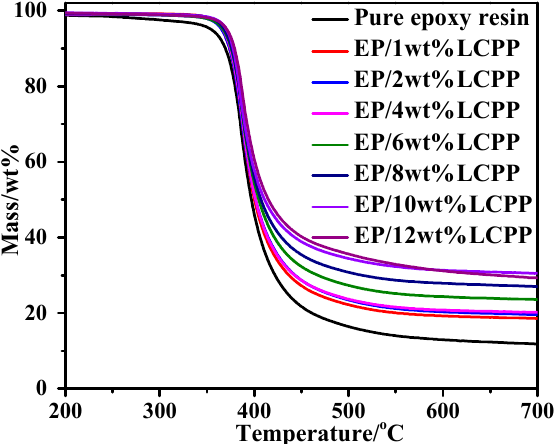
Figure 3. TGA curves of pure epoxy resin and the EP/LCPP composites. Table 2. The results of the TGA for pure epoxy resin and EP/LCPP composites.